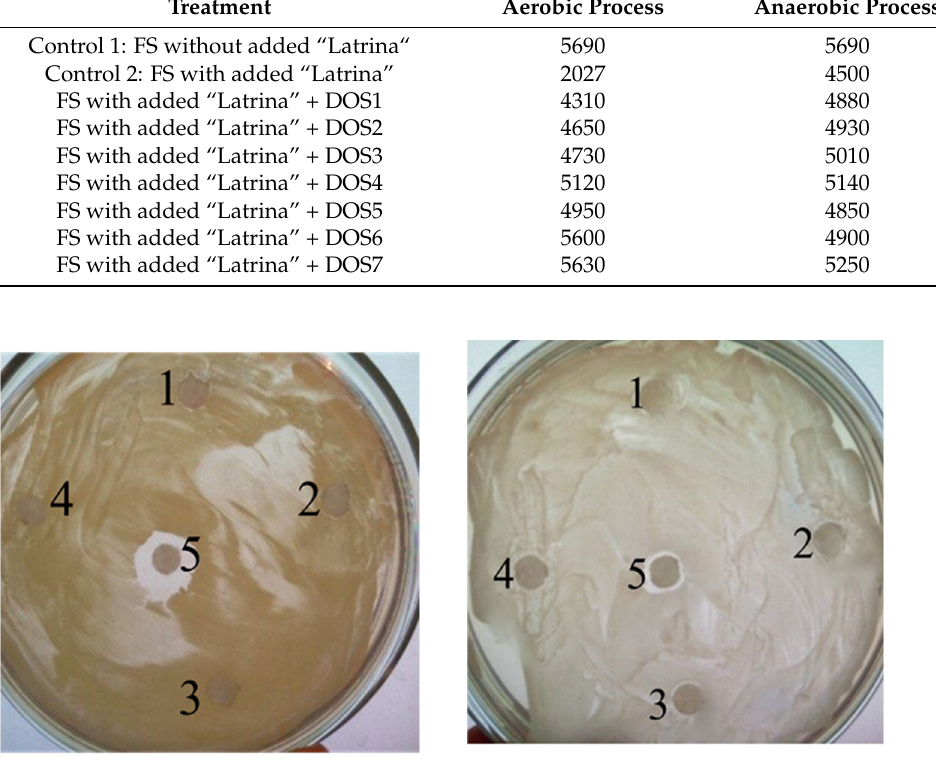
Figure 3. Disk-diffusion bioassay using M. luteus NCIMB 13267 ( a ) and Y. lipolytica 367-2 ( b ) as test cultures: 1—FS with DOS 1; 2—FS with DOS 6; 3—FS with DOS 4; 4—FS with DOS 7; 5—Control